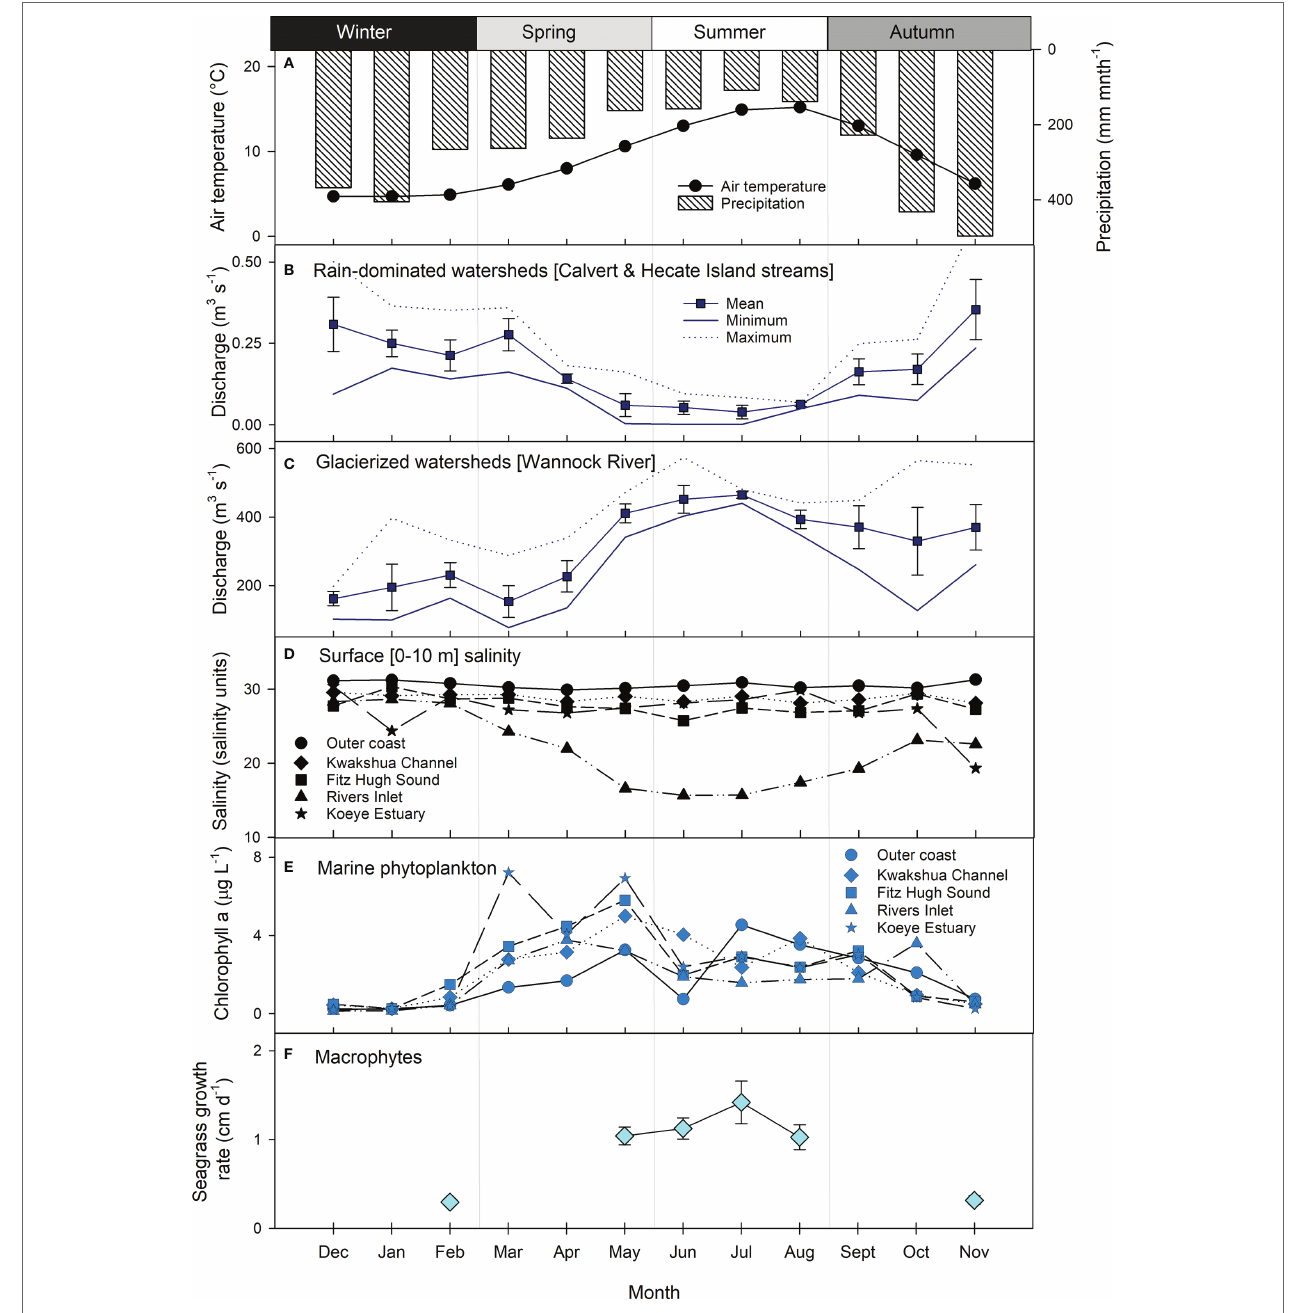
FIGURE 2 | Seasonality indicators across freshwater and marine ecosystems of the NPCTR: (A) mean monthly air temperature (circles) and precipitation (bars) at sea level (Addenbroke Island 1981-2010 normal, Environment and Climate Change Canada station 1060080, 21 m.a.s.l.); mean monthly ± SD stream/river discharge summary statistics (mean ± SD, minimum, maximum) for the period 2015-2018 from (B) rain-dominated watersheds represented by Calvert and Hecate Island streams ( Korver et al., 2020 ), and (C) glacierized watersheds represented by the Wannock River (station 08FA002); (D) mean monthly surface (0-10 m) water salinity across the study region, (E) mean monthly chlorophyll a concentrations as representative of marine phytoplankton biomass across the study region; (F) mean ± SD in seagrass growth rate representing the marine macrophyte end-member. Outer coast is station QCS01, Kwakshua Channel is the mean of stations Pruth, KC7 and KC10, Fitz Hugh Sound is the mean of stations FZH08, FZH01, UBC7 and RVRS01, Rivers Inlet is the mean of stations DFO2, DFO5 and UBC8, and Koeye Estuary is station